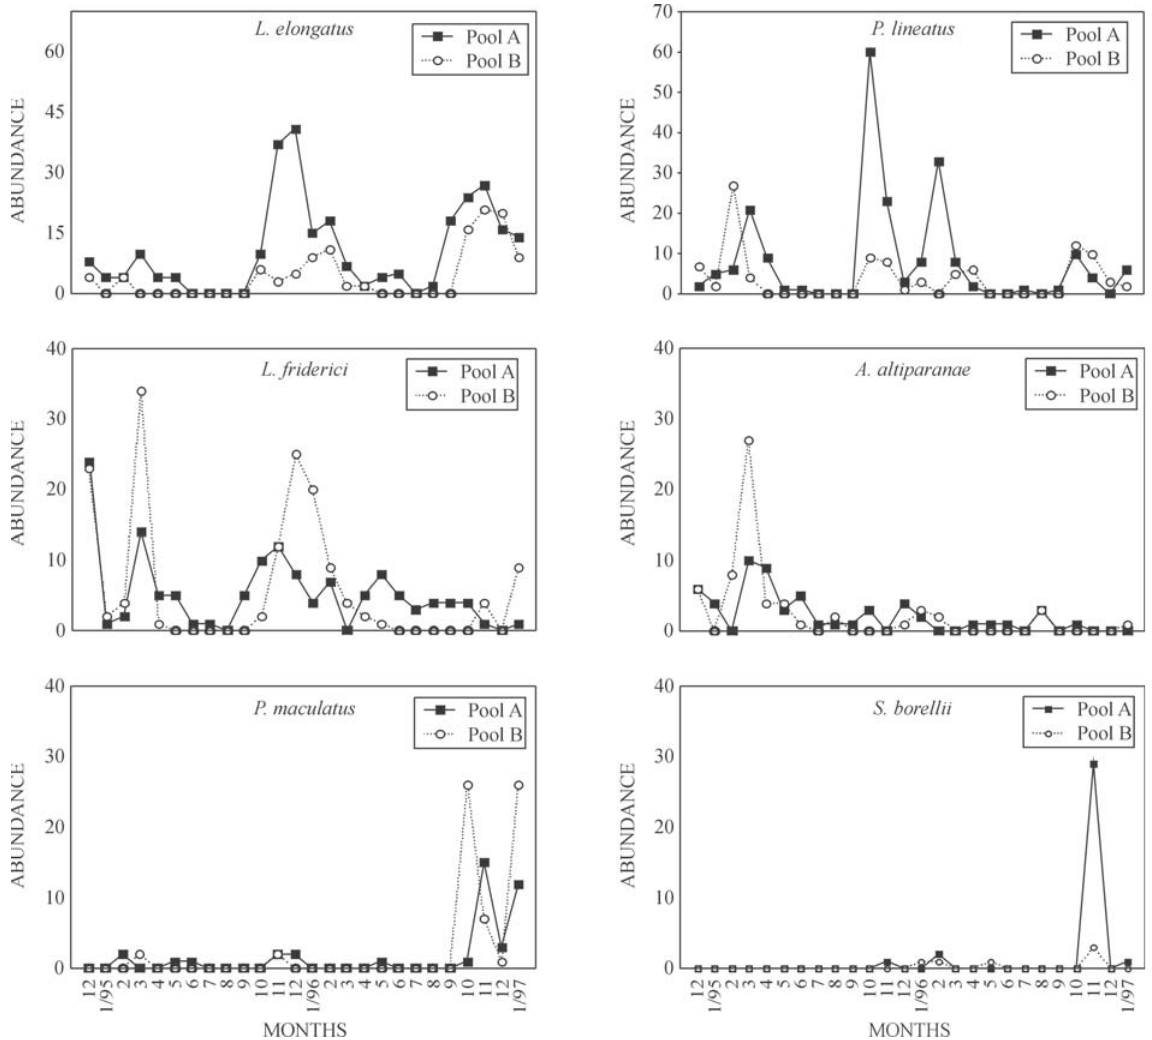
Fig. 3. Monthly variations in abundance of the main middle- and large-sized species in the experimental fish ladder (Pool A = 10 m, Pool B = 27 m) located near Itaipu